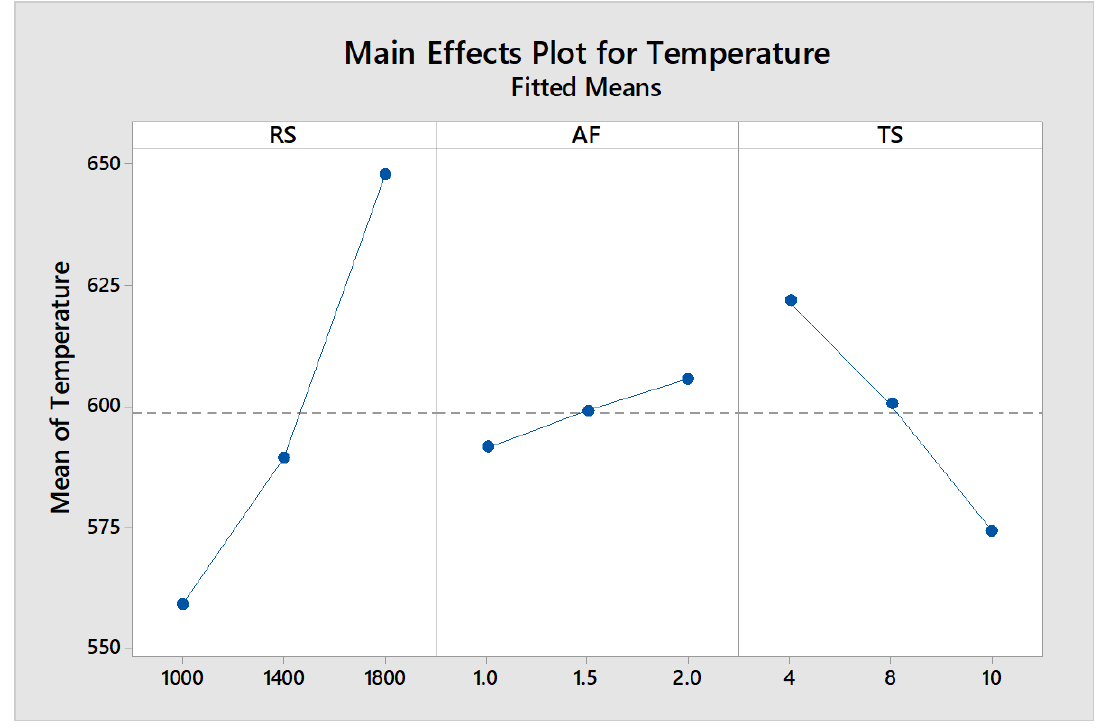
Figure 29. Main e ff ects plot—temperature. Figure 29. Main effects plot — temperature. Figure 29. Main effects plot — temperature.